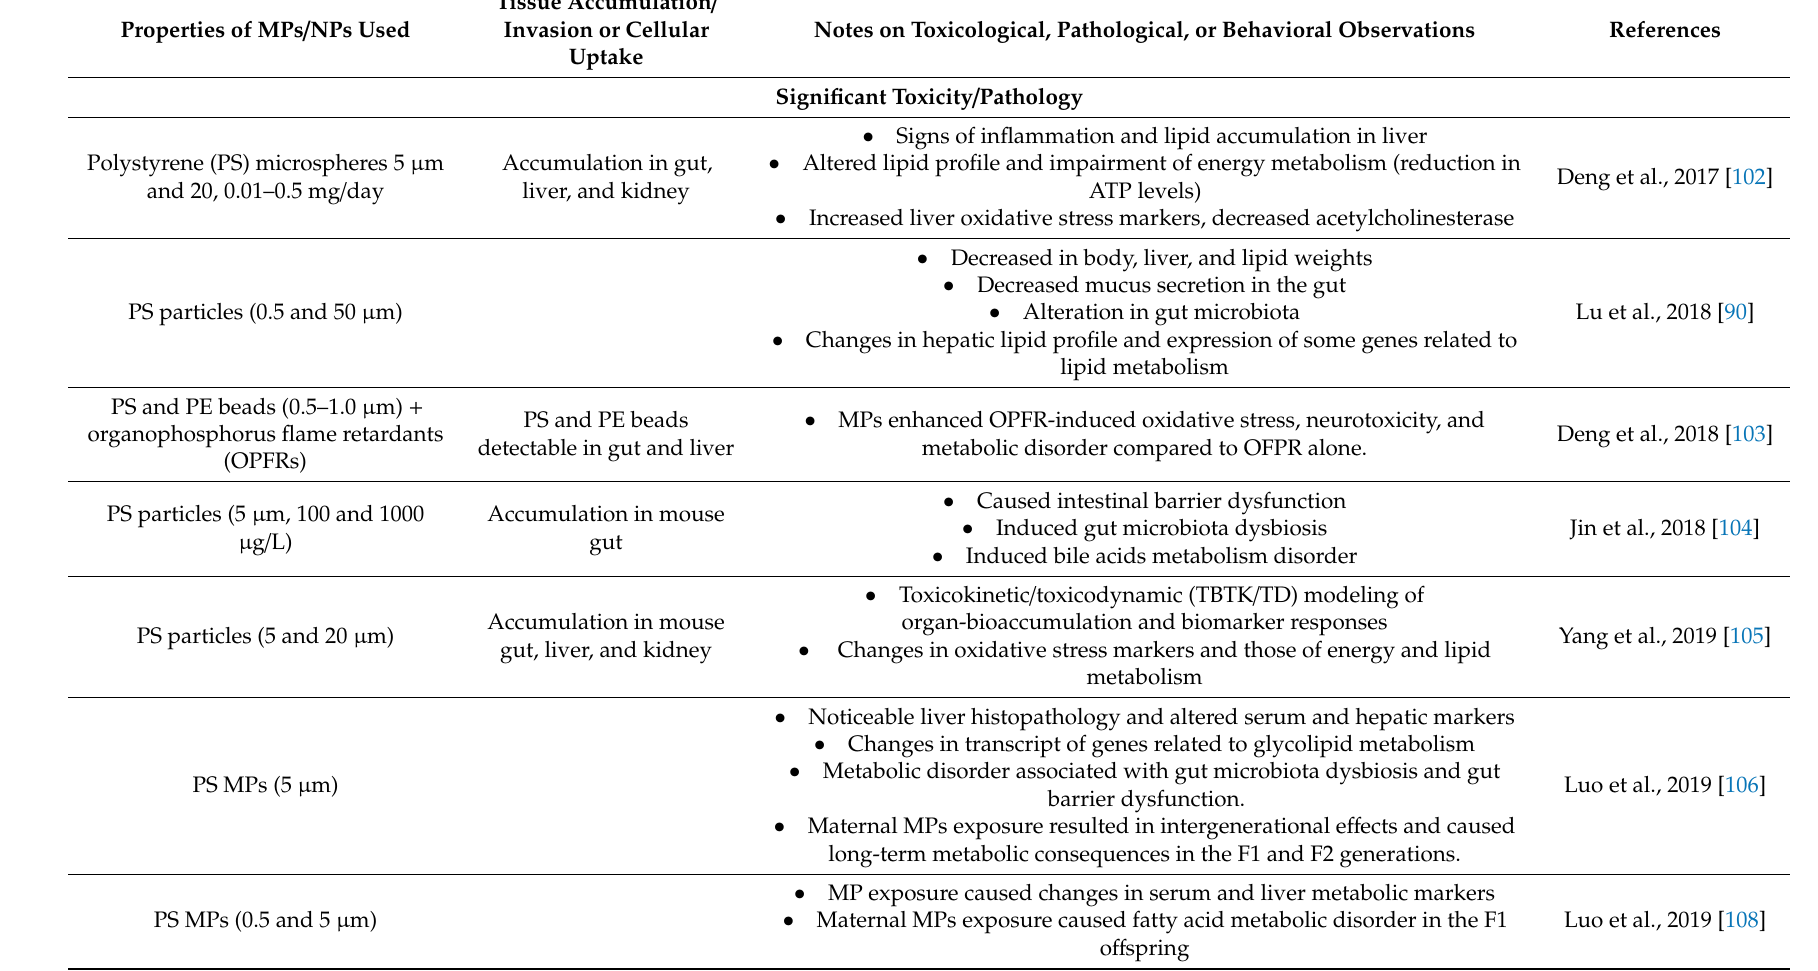
Table 2. A summary of notable toxicological and / or pathological findings associated with MPs / NPs in mouse. PS, polystyrene; PE, polyethylene; PVC, polyvinylchloride; NPs, nanoplastics ( < 1 µ m); MPs,